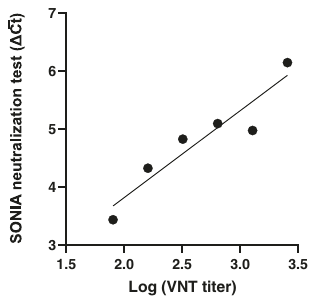
Fig. 4 Correlation between the SONIA neutralization test and VNT titers. The SONIA neutralization PCR test signals were averaged for samples with the same PRNT titers and plotted on the y-axis. Considering the PCR signals were logarithmic in nature, the VNT titers were log-transformed and plotted on the x-axis. The VNT was performed by the Mayo Clinic. The y-axis is the SONIA neutralization PCR test signal Δ Ct calculated by subtracting the Ct value of the sample from that of a buffer only blank control.